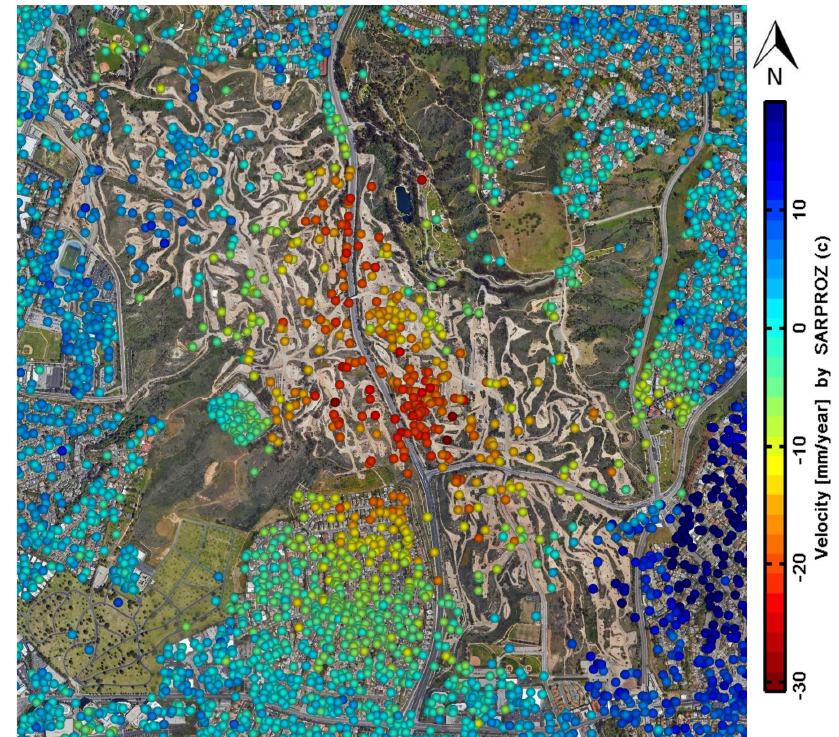
Figure 5. Deformation map in the Inglewood